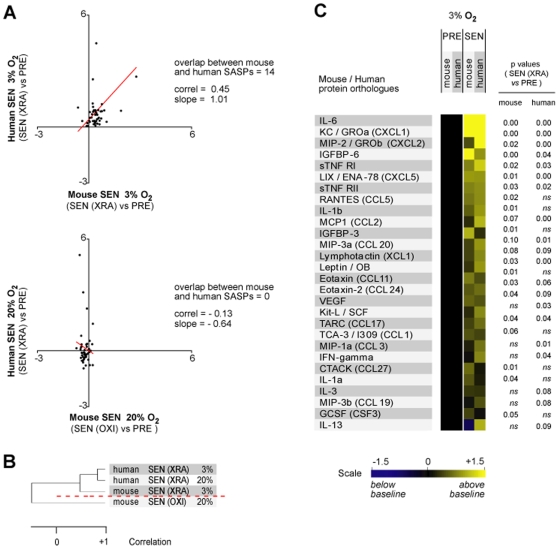
Orthology analyses of human and mouse secretory profiles.A) Correlation between human and mouse SEN cells cultured and induced to senesce in 3% O2 (top panel) and 20% O2 (lower panel). Baselines for each SEN profile are the secretory profiles of PRE cells cultured under the same O2 concentration (see Datasets S2, S3). B) Unsupervised hierarchical clustering analysis of cells in A. C) Direct comparisons of the secretory profiles of human and mouse cells cultured in 3% O2.